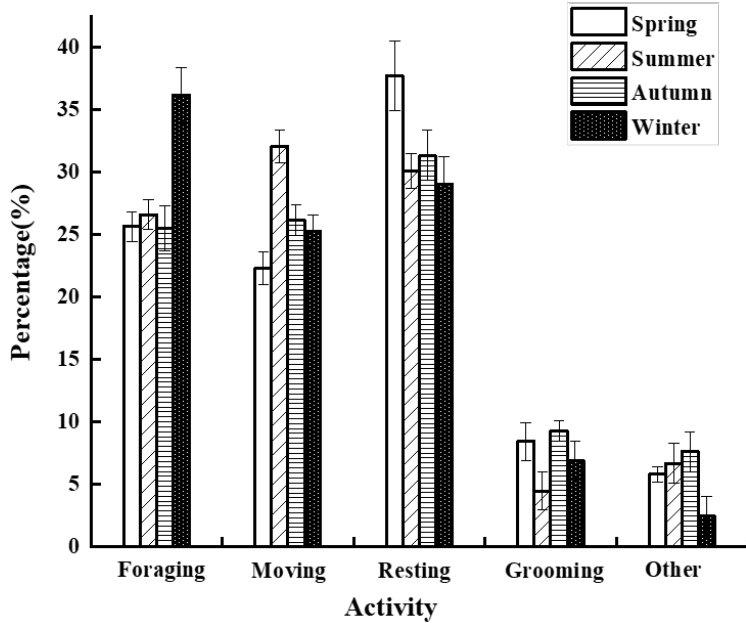
Figure 3. Seasonal variations in the time budgets of various activities.